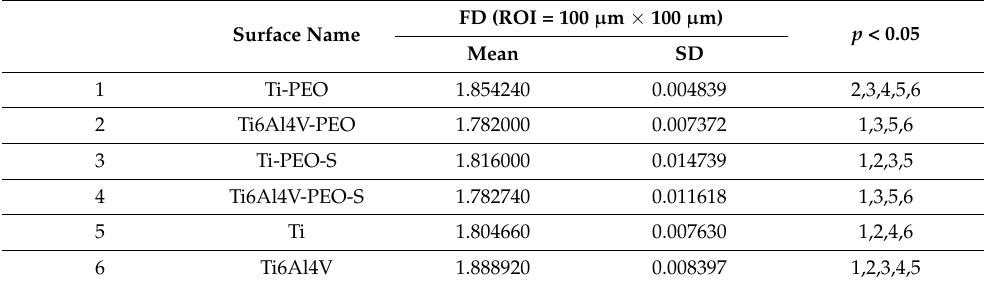
Table 3. Post hoc ANOVA results (least significant difference) for comparison of fractal dimension for ROI size 100 µ m × µ m between each examined surface.